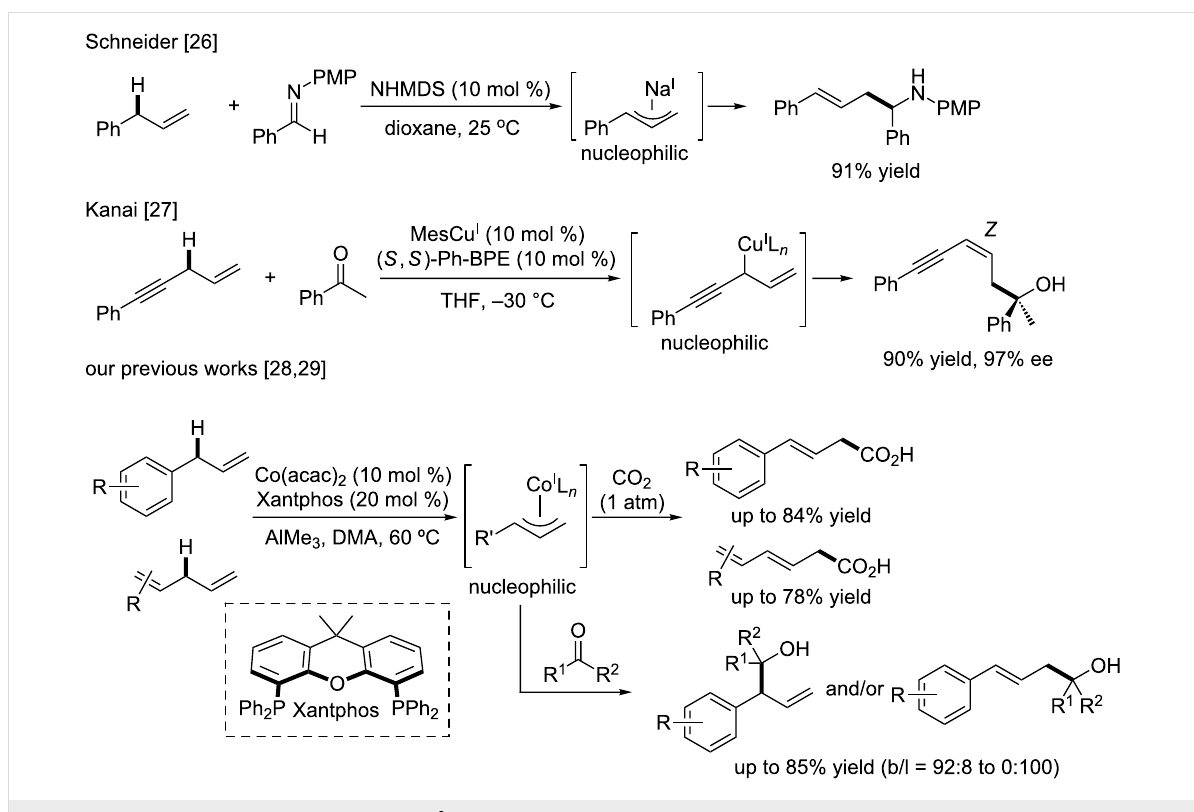
Figure 1: Precedent examples of catalytic allylic C(sp 3 )–H additions to carbonyl